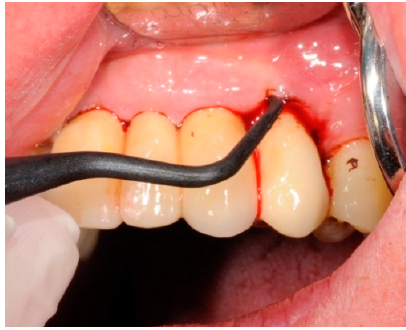
Figure 7. Teflon-curettes debridement to remove the deposits.